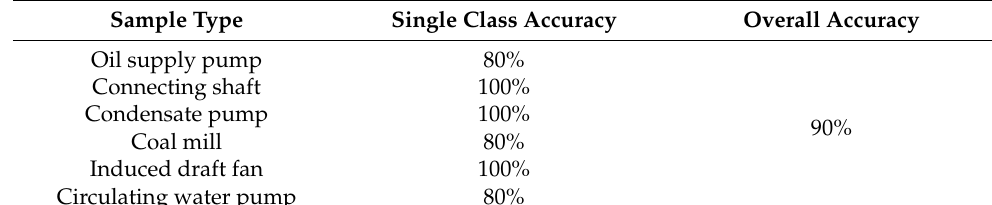
Table 2. Classification accuracy of raw data.